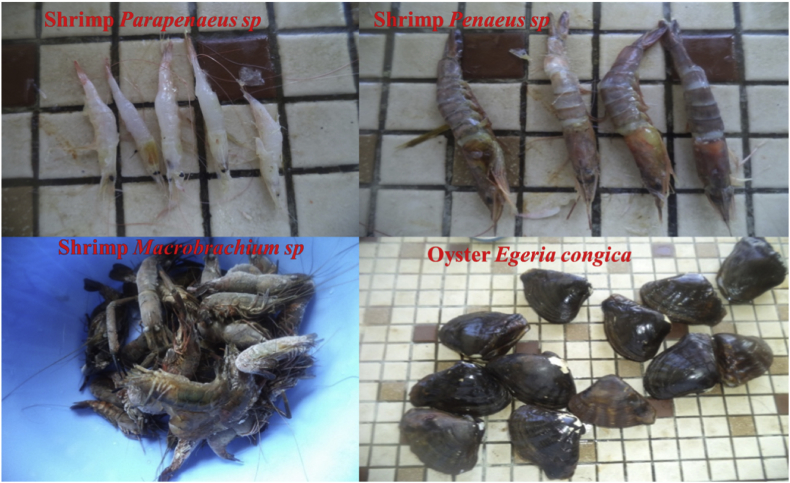
Analyzed oysters and shrimp from Atlantic Coast of Muanda, Democratic Republic of the Congo. Photos taken by Robert B. Suami in November 2017.